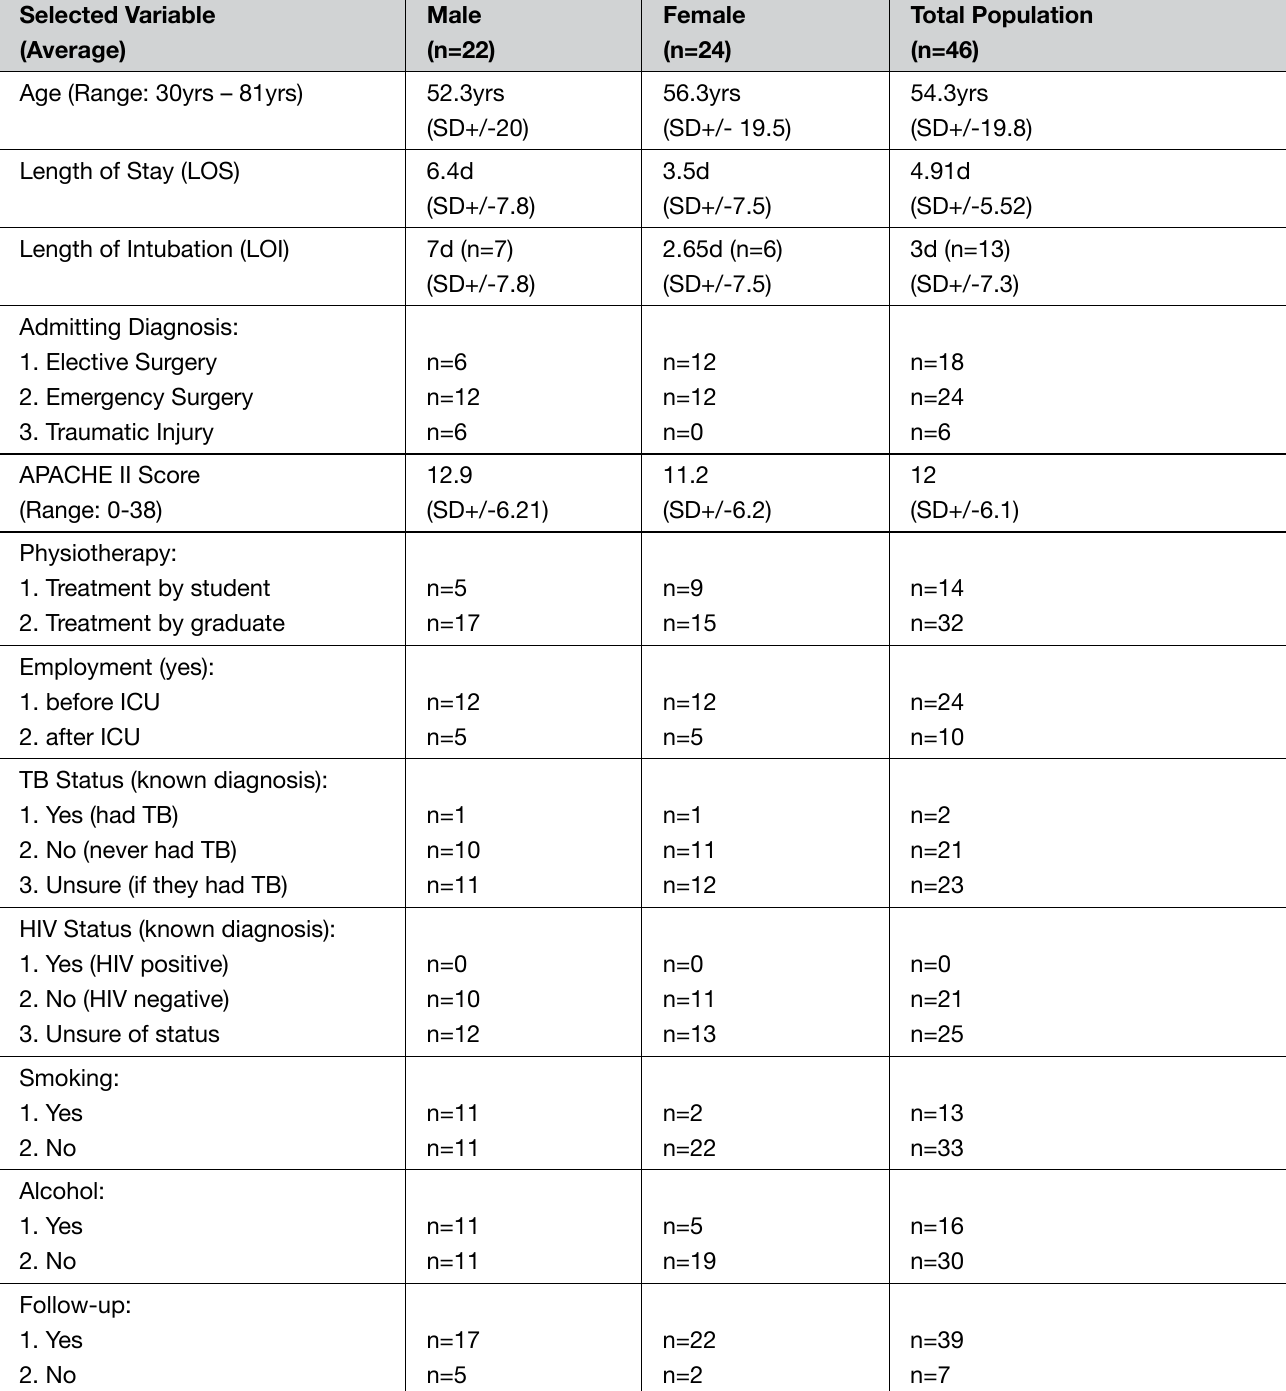
Table 1. Sociodemographic and clinical variables of the participants